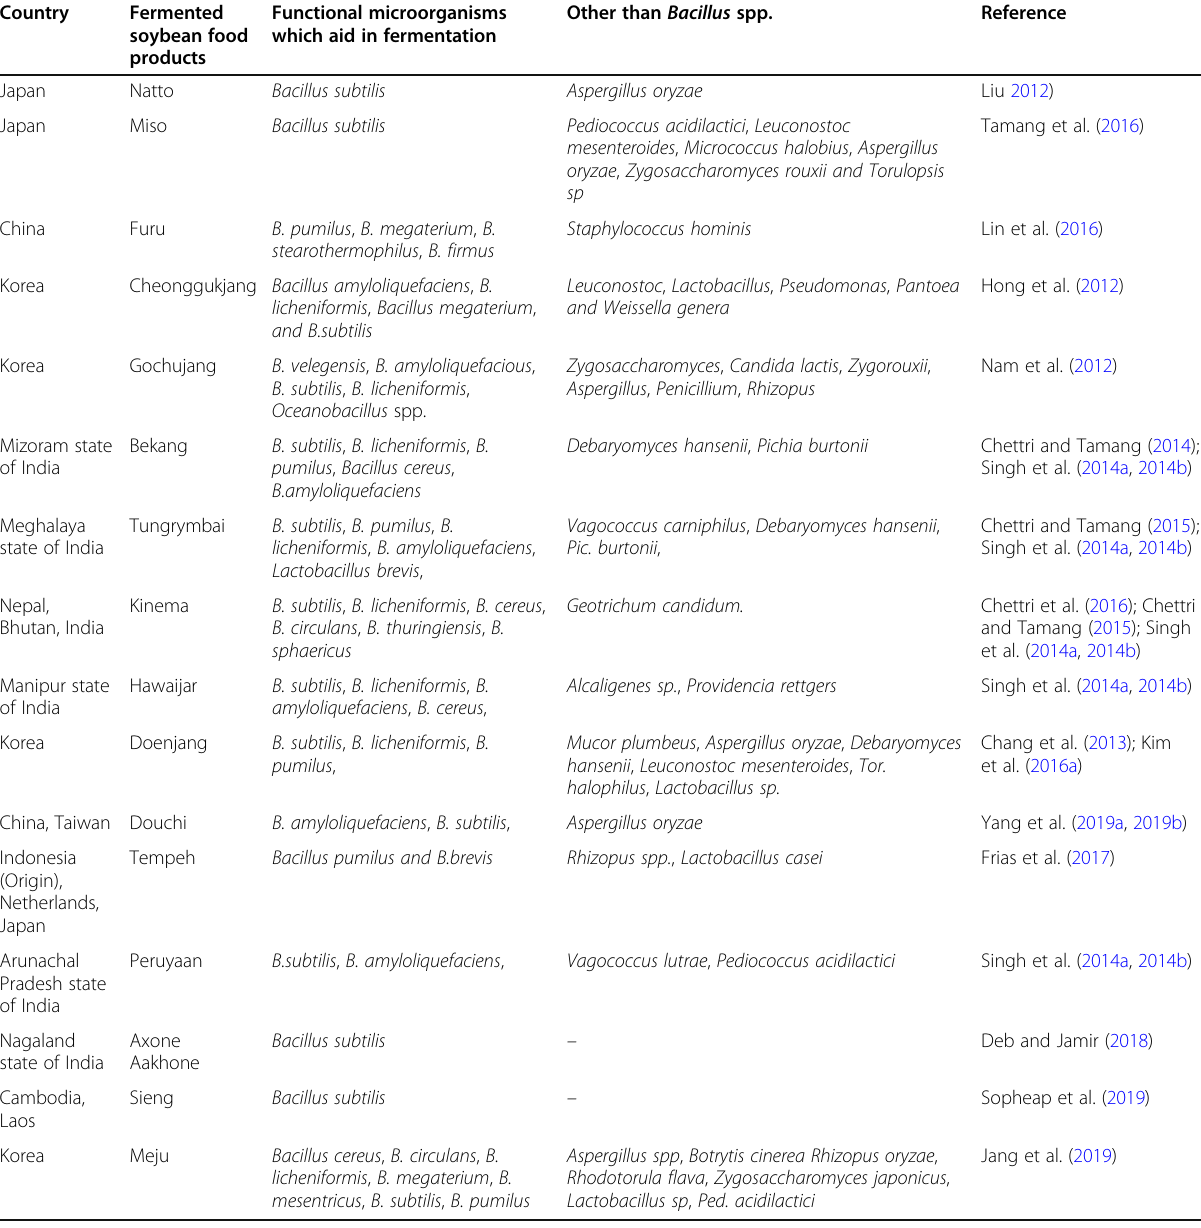
Table 1 Geographical distribution of common fermented soybean food products of Southeast Asian